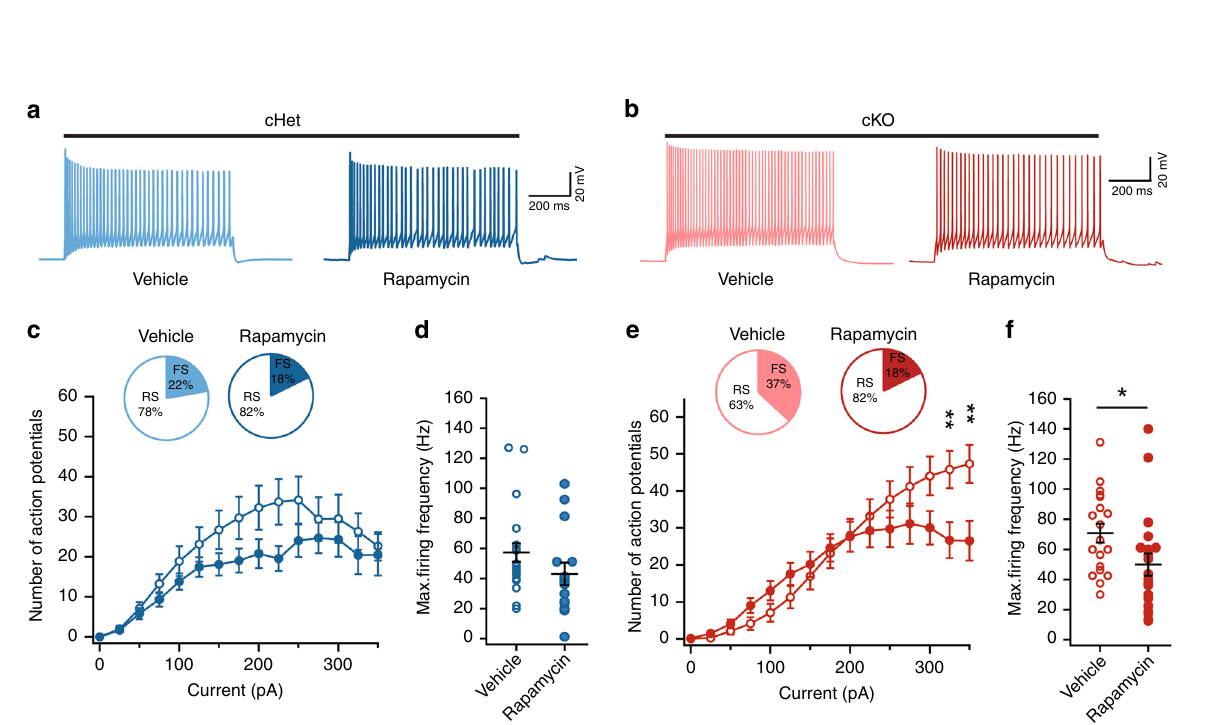
Fig. 9 Rapamycin treatment decreases fast-spiking phenotype in SST-Cre lineage CINs in cKO mice. a , b Example voltage traces in response to suprathreshold current injections in SST + CINs from vehicle and rapamycin treated cHet ( a ) and cKO ( b ) mice. c , d Comparison of fi ring output: Two-way ANOVA (F 14, 475 = 0.63, P = 0.83); and maximum fi ring frequency: Two-way unpaired t -test (t 33 = 1.4, p = 0.15) of tdTomato + CINs in vehicle and rapamycin treated cHet mice (Vehicle, n = 18 from 2 mice; Rapamycin, n = 17 cells from 2 mice). Inset, pie charts showing the proportion of SST + CINs with RS and FS physiological properties in each treatment group. e , f Same as ( c , d ) for vehicle and rapamycin treated cKO mice. Note the CINs from rapamycin treated cKO mice have lower fi ring output: Two-way ANOVA with Bonferroni ’ s test (F 14, 555 = 2.86, P = 0.003; 325 pA, p = 0.004 and 350 pA, p = 0.001), and maximum fi ring frequency: Two-way unpaired t -test (t = 2.1, p = 0.04); (Vehicle, n = 19 cells from 2 mice; Rapamycin, n = 20 from 2 37 mice). Inset, pie charts showing the proportion of SST-lineage CINs with FS and RS physiological properties in each treatment group. Data are presented as mean ± SEM in all graphs. * p < 0.05, ** p < 0.01, **** p < 0.0001. Source data are provided as a Source Data fi